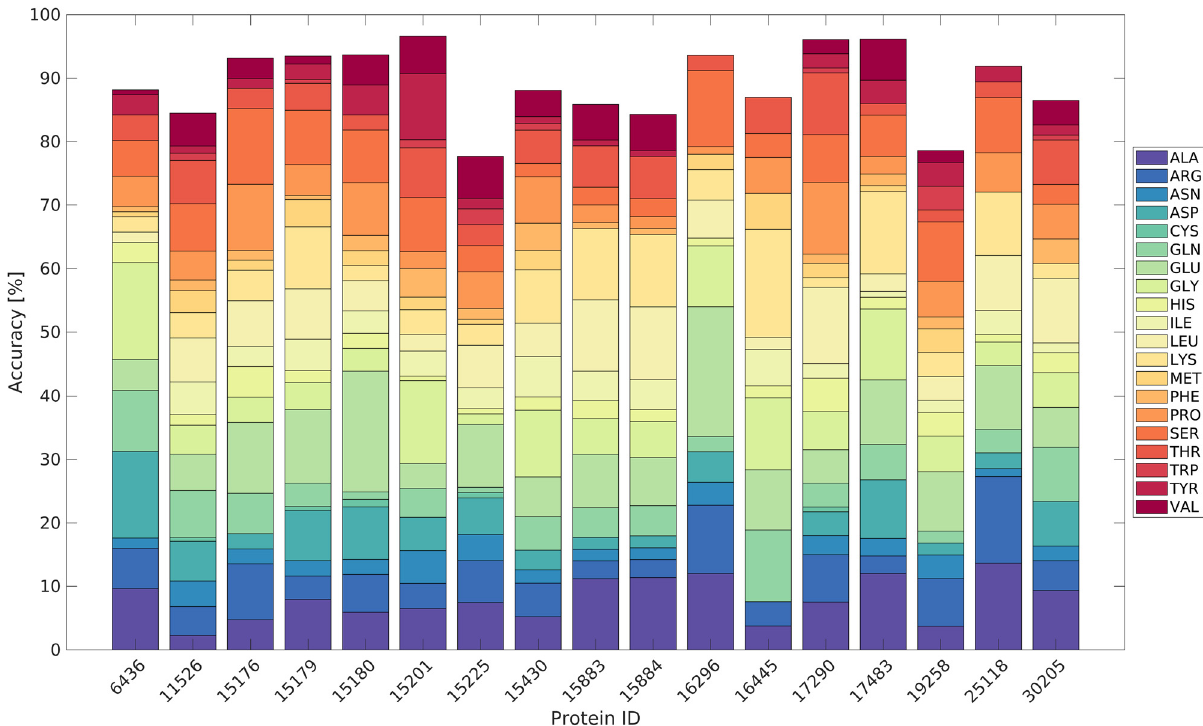
Fig 3. Classification accuracy for LDA using H N , N, CO, C α , C β , H α and H β chemical shifts. We performed leave-one-out cross-validation with NMR data from the 17 proteins, downloaded from the BMRB. Amino acid distributions are shown as percentages of each type present in each protein.